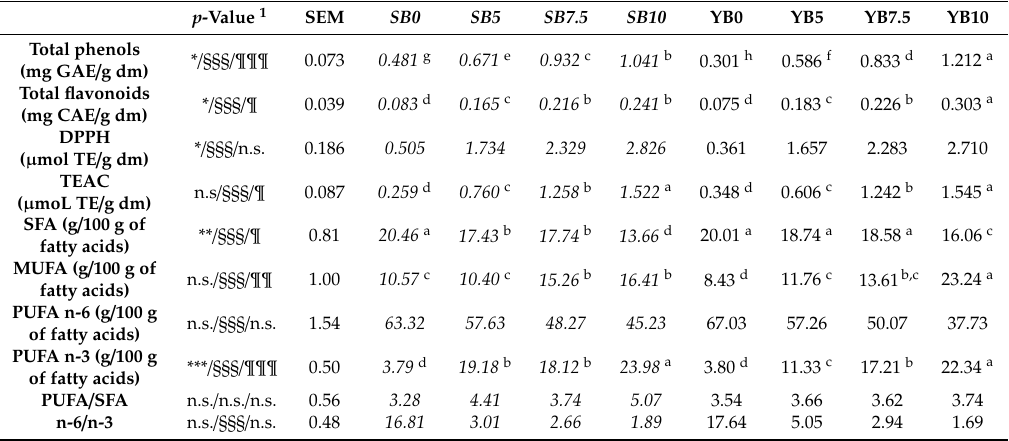
Table 7. E ff ect of leavening agent and of flaxseed cake percentage on the total phenolic content, total flavonoids, anti-radical activity, and fatty acids in cooked bread samples. Data reported in italics were already published in Sanmartin et al., 2020